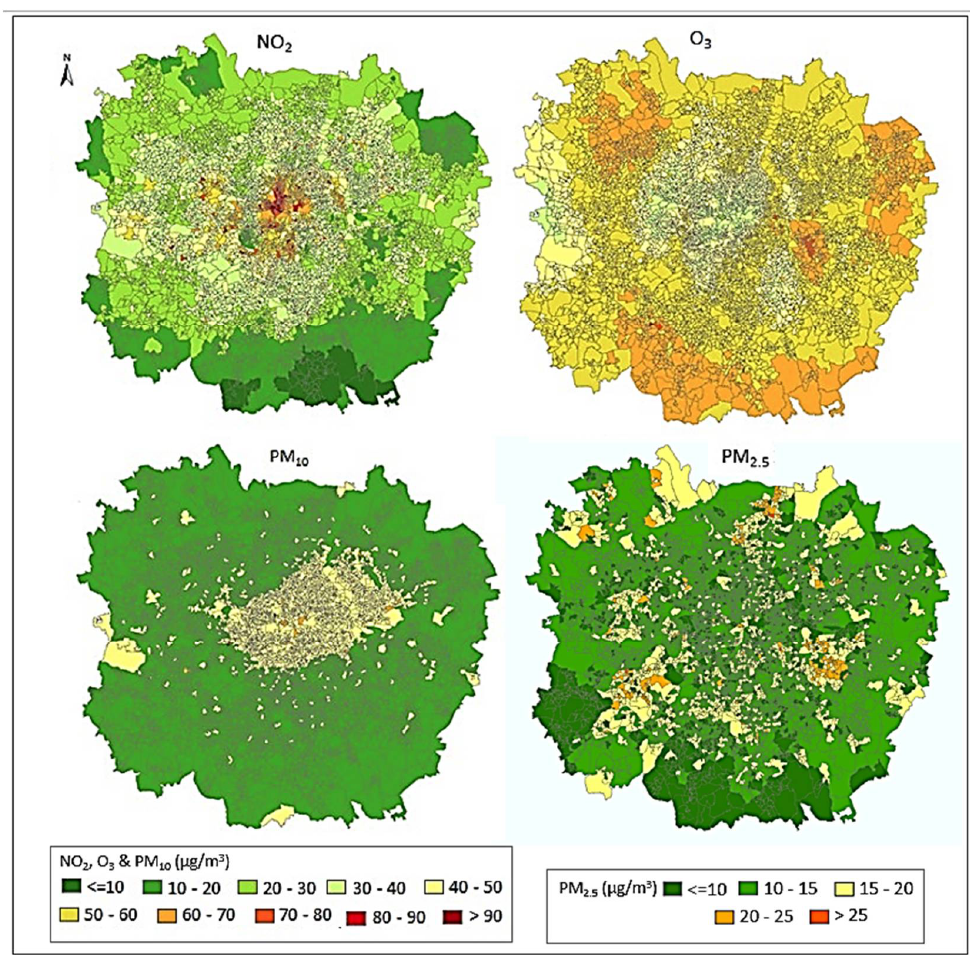
Figure 4. Long-term average (years 2009–2013) of estimated NO 2 (24 h; μg/m 3 ), O 3 (8 h-max; μg/m 3 ), PM10 (24 h; μg/m 3 ) and PM2.5 (24 h; μg/m 3 ) concentrations from the hybrid 2 model, per LSOA in the Greater London Area. Hybrid 2: Combination of estimates derived from independent exposure assessment methods, within a GAM.